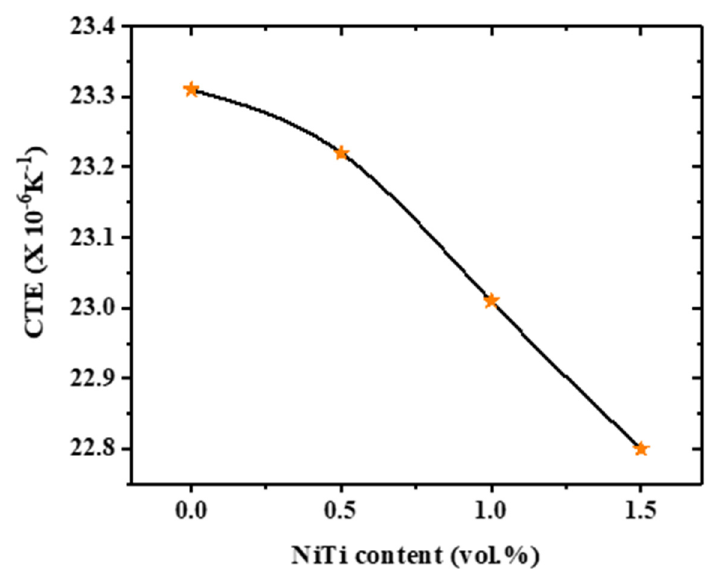
Figure 6. Effect of NiTi content on the coefficient of thermal expansion (CTE). Figure 6. E ff ect of NiTi content on the coe ffi cient of thermal expansion